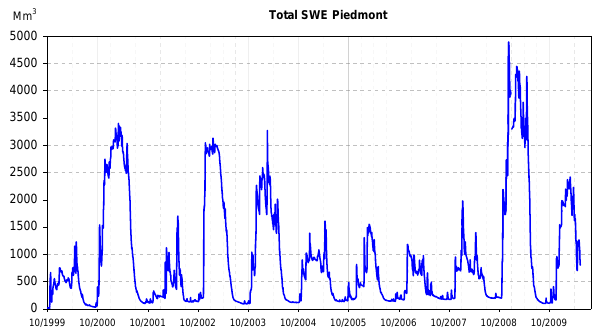
Figure 5. Snow Water Equivalent (SWE) calculated for the Piemonte Po basin area from October Fig. 5. Snow Water Equivalent (SWE) calculated for the Piemonte 1999 to February 2010. Po basin area from October 1999 to February